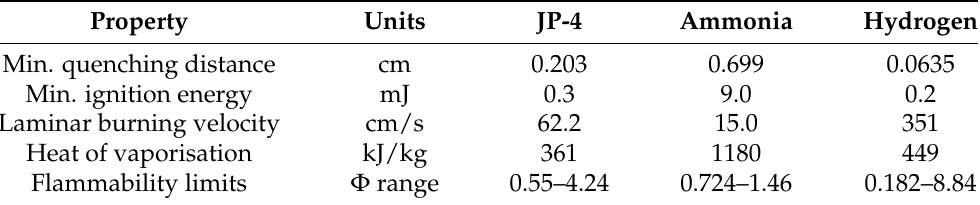
Table 1. The combustion properties of JP-4, ammonia, and hydrogen, adapted from [12]. The min- imum quenching distance and minimum ignition energy are determined experimentally at 1 atm. The laminar burning velocity is determined experimentally at 422 K (300° F) and 1 atm. The heat of vaporisation is a referenced value, and the flame stability limits are generalised from the gas turbine (GT) burner. JP-4 is no longer manufactured, but its properties are very similar to modern jet fuel [20].